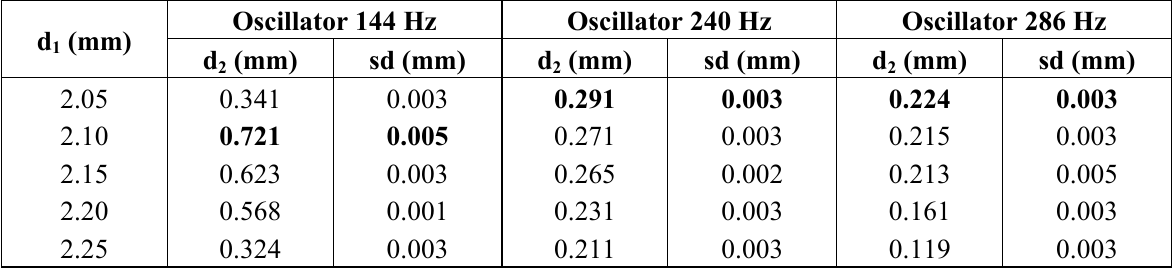
Table 4. Results of the measurement of the displacement d as the highest amplitude to 2 configure the optimal distance d between the centre of the magnetic sphere and the 1 membrane (bolded values are the distances chosen for further investigations).